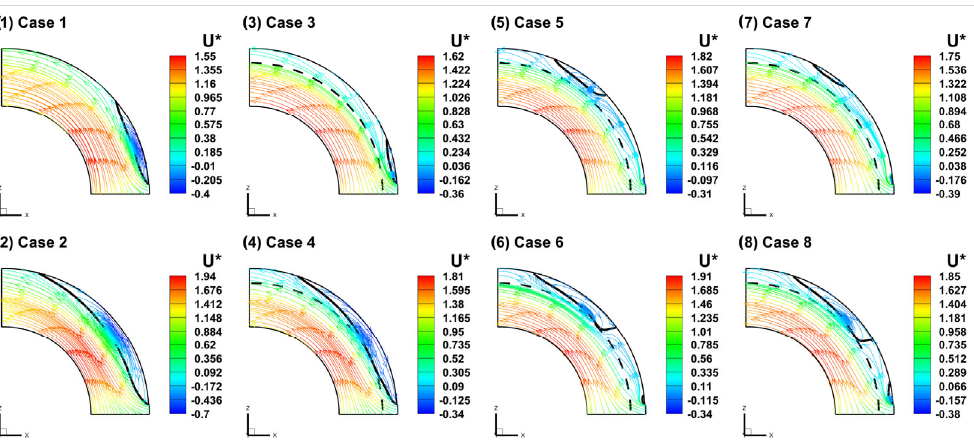
Figure 9. Contours and 2-D streamlines of dimensionless streamwise velocities on the vertical section near the water surface in the curved reach after the confluence point. (The black dashed line and black solid line in the figure represent the edge of vegetation region and the border of separation zone, respectively).